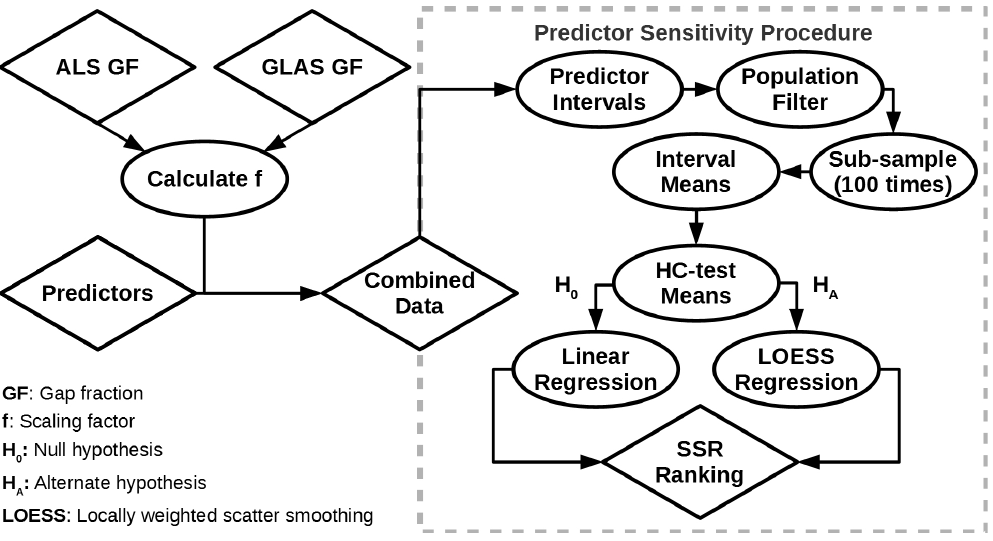
Figure 3. Methodological workflow for obtaining Squared Sum of fitted model Residuals (SSR) for independent predictor ranking from ALS and GLAS